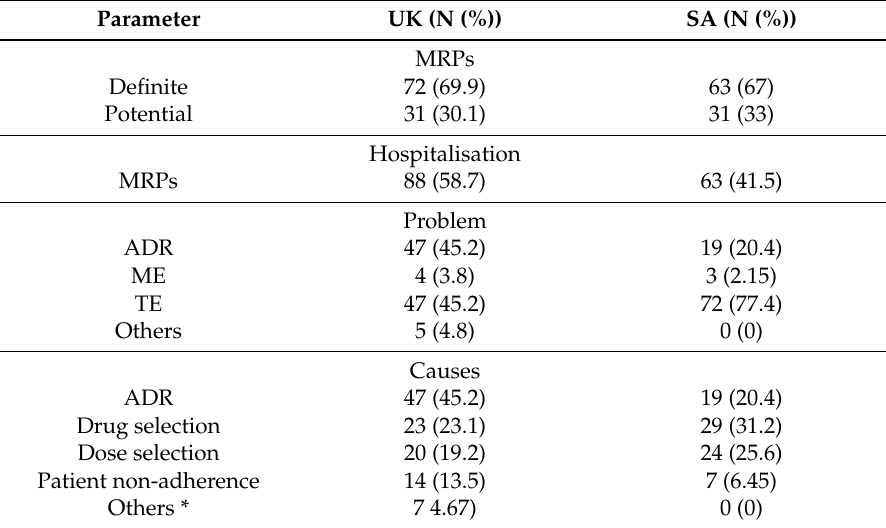
Table 3. Medicine-related problems’ prevalence and characteristics in each country.